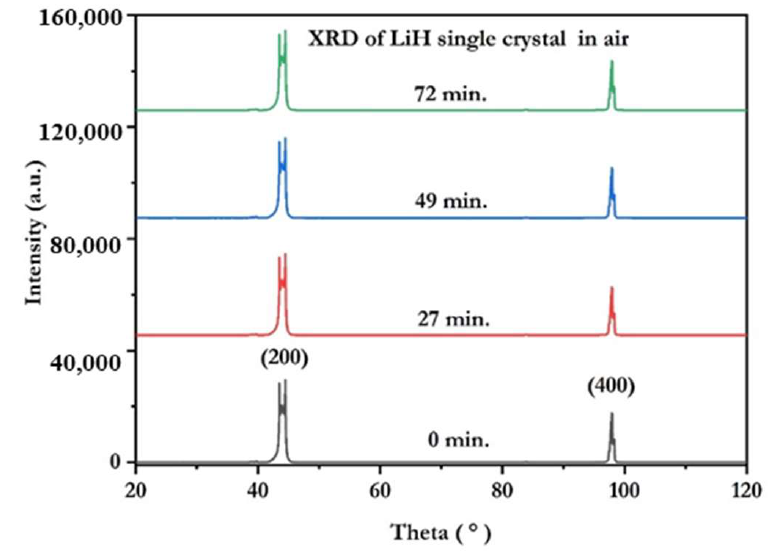
Figure 15. XRD pa(cid:308)ern of LiH single crystal in air. Figure 15. XRD pattern of LiH single crystal in